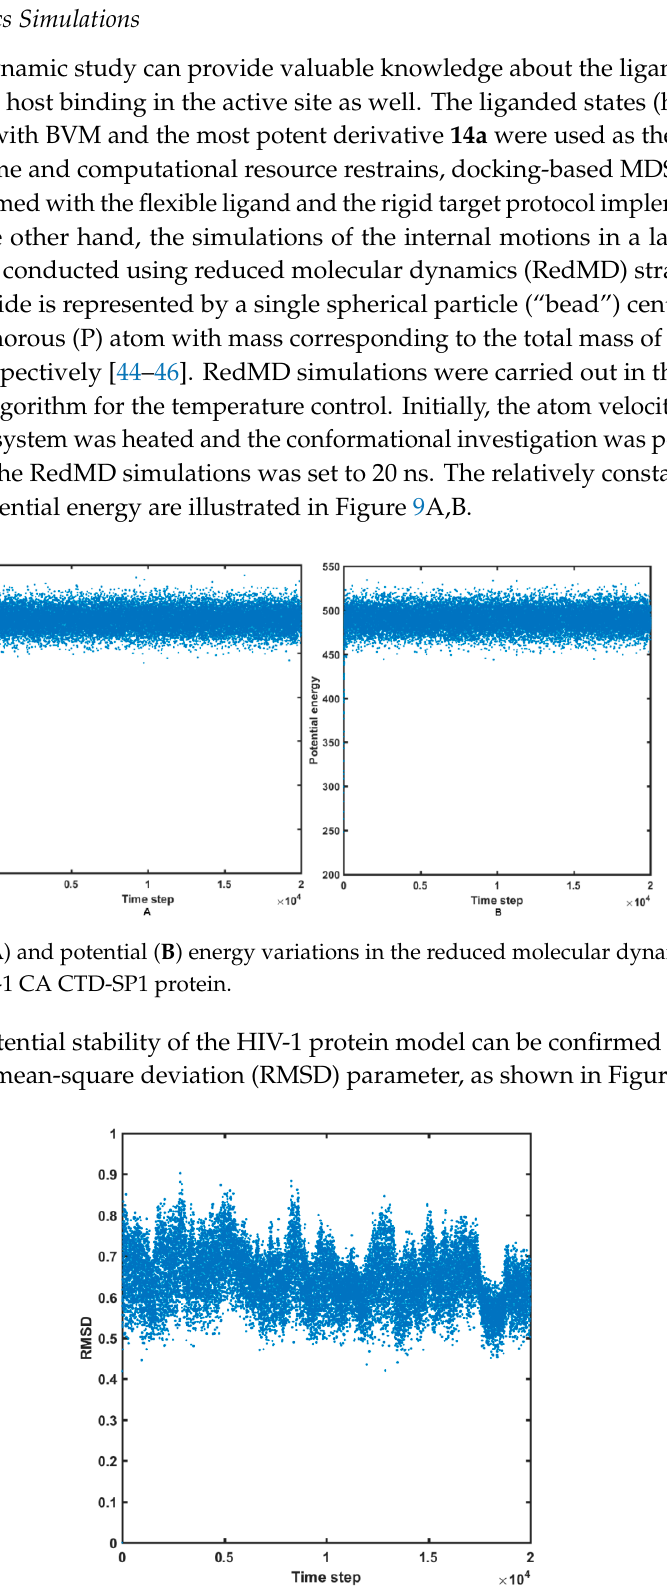
Figure 10. Root-mean-square deviations (RMSDs) of HIV-1 CA CTD-SP1 protein “bead” atoms in RedMD simulations.